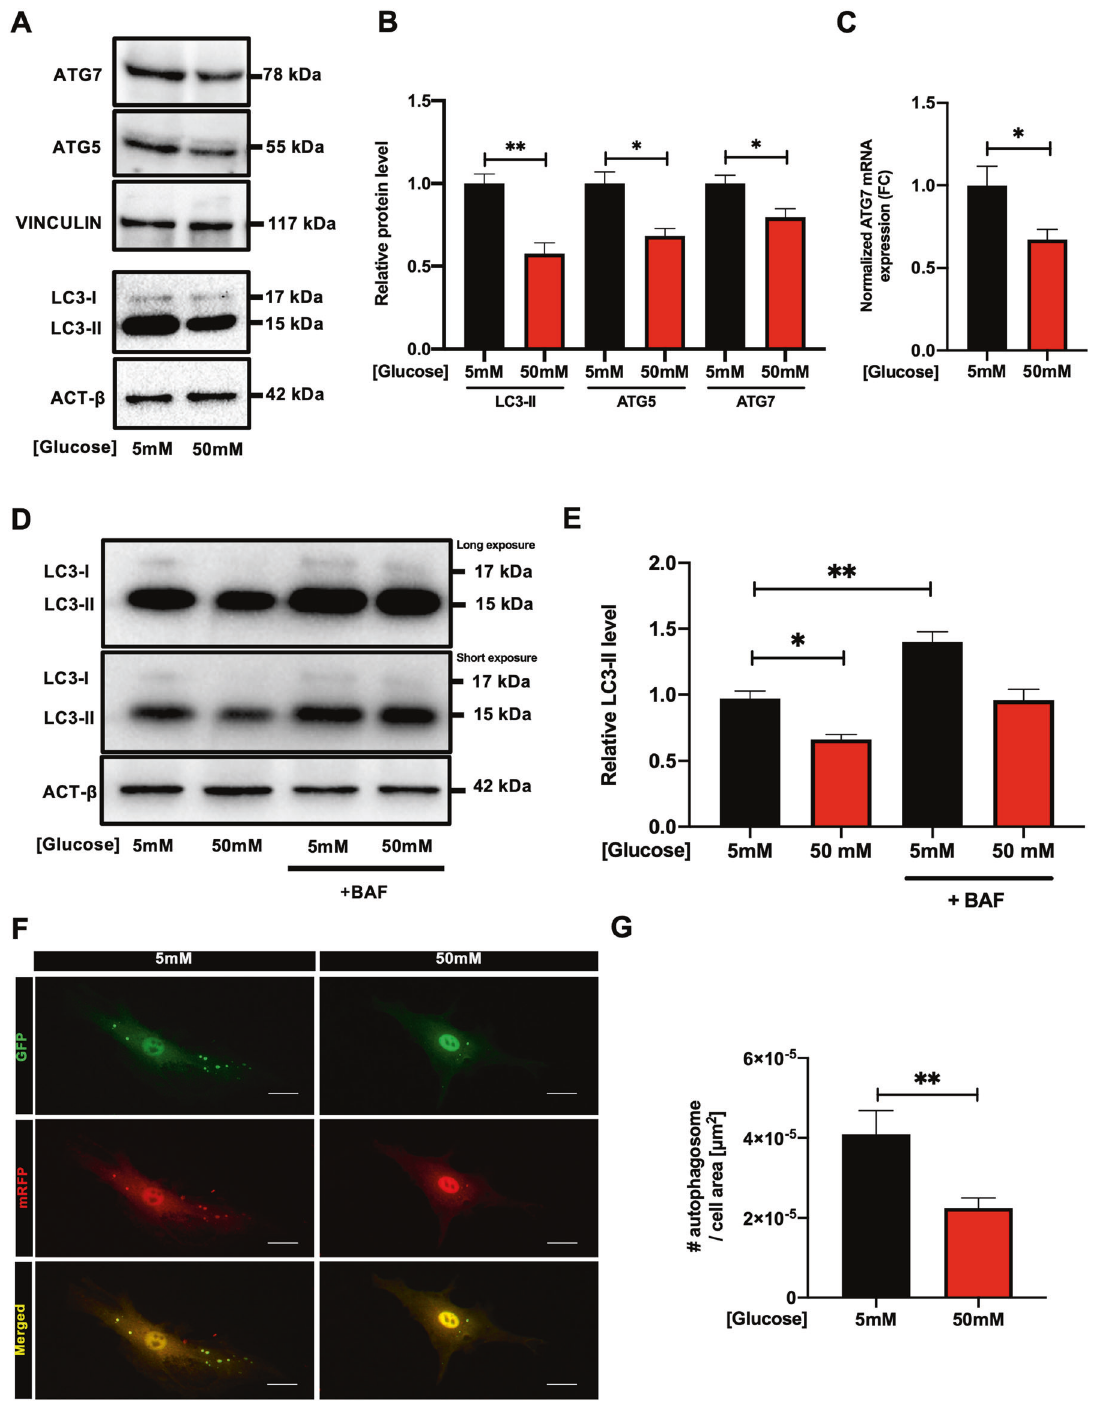
Fig. 5 Autophagy is reduced in CSCs exposed to high-glucose concentration. Representative WB panels (A) and relative densitometric quanti fi cation (B) of LC3-II ( n = 8), ATG5, and ATG7 protein expression after exposure for 24 h to 5 mM or 50 mM glucose ( n = 3). C ATG7 mRNA expression levels after 24 h of culture in 5 mM or 50 mM glucose (n = 5). Representative WB panels (D) and relative densitometric quanti fi cation (E) of LC3-II expression pro fi le after 24 h of exposure to 50 mM glucose, with or without treatment for 2 hours with 100 nM ba fi lomycin A1 (BAF) ( n = 4). LC3-I and II panel is displayed twice with different exposure times, for the optimized detection of the two bands (higher exposure, top panel; lower exposure, lower panel). F Representative fl uorescence microscopy images of Ad-mRFP-GFP-LC3 transduced cells, exposed for 24 h to 50 mM glucose or 5 mM glucose as control. G Corresponding quanti fi cation of the number of mRFP + /GFP + autophagosomes per cell surface area in 50 mM glucose or 5 mM control ( n = 3). Scale bars = 20 µm. * P <0.05, ** P